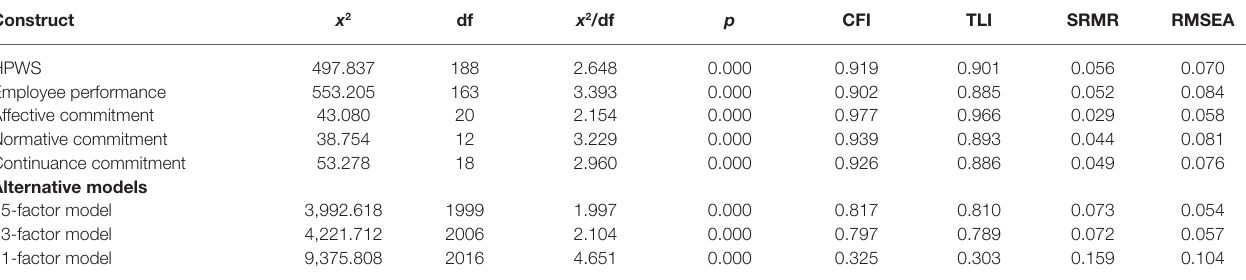
TABLE 2 | Confirmatory factor analysis.